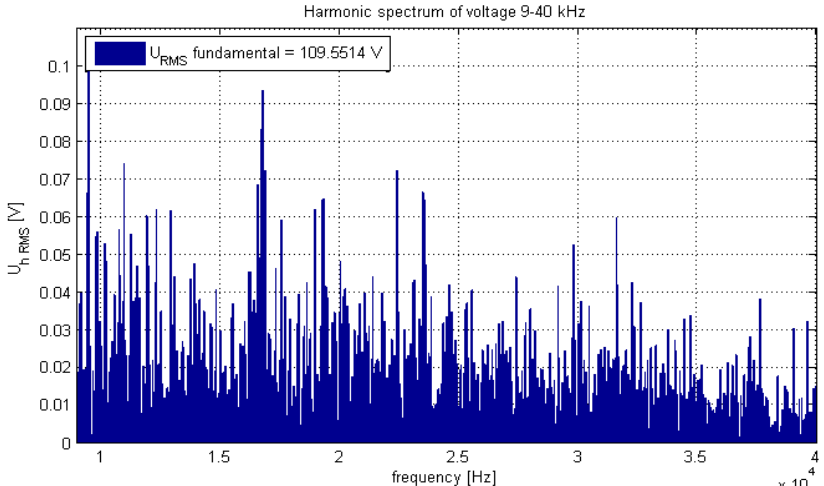
Figure 5. Harmonic decompositions of voltage and current in the range (2–9) kHz: ( top )—volage; ( down )—current.